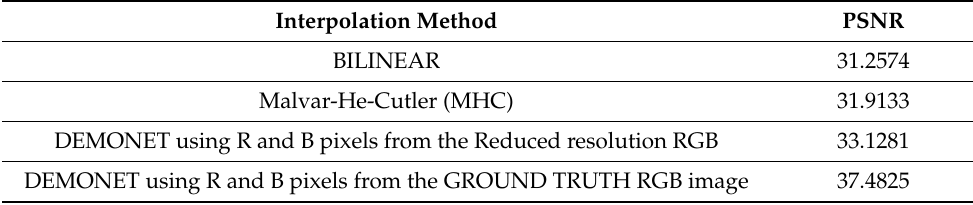
Table 1. Peak signal-to-noise ratio (PSNR) of pan bands generated by using di ff erent interpolation methods.